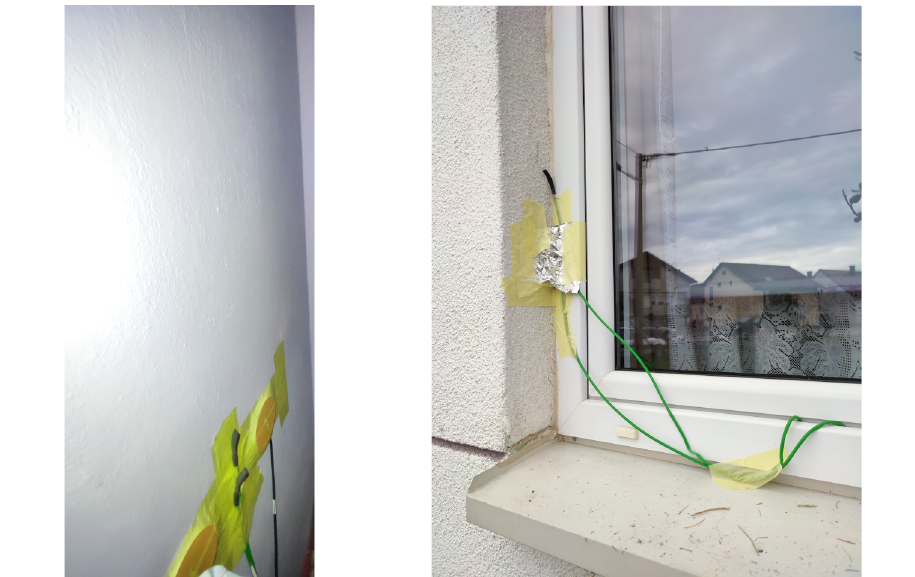
Figure 6. Experimental setup for the pilot in-situ